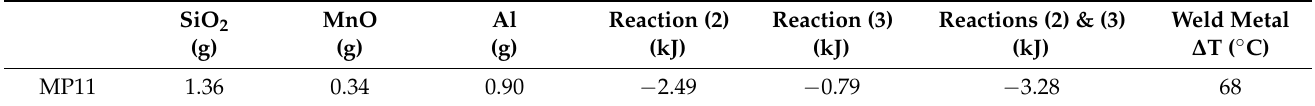
Table 4. Exothermic heat added to the weld pool from reactions (2) and